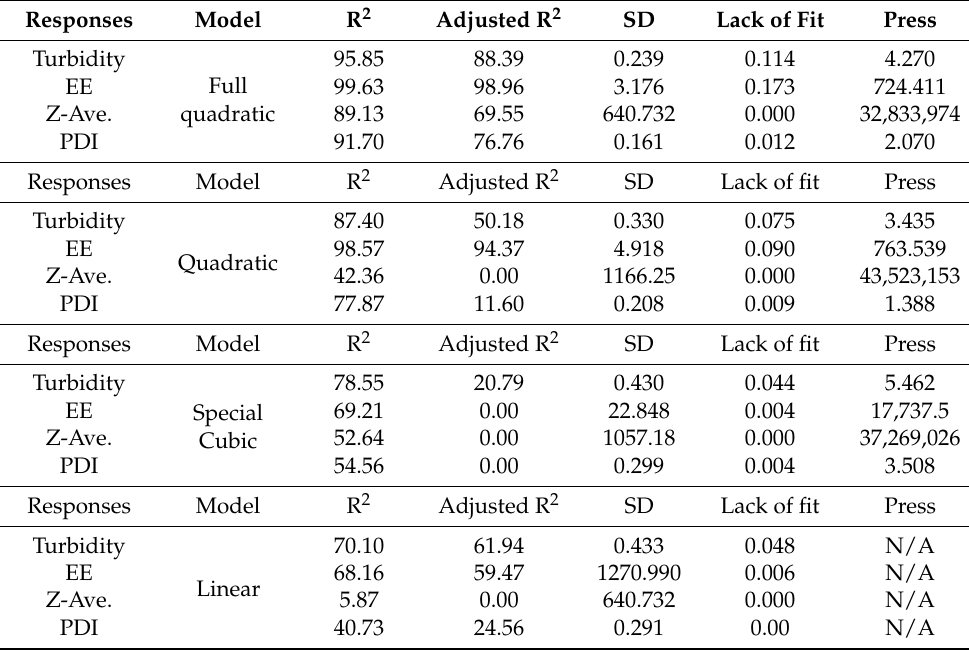
Table 6. Regression results of the response surface models’ fit.